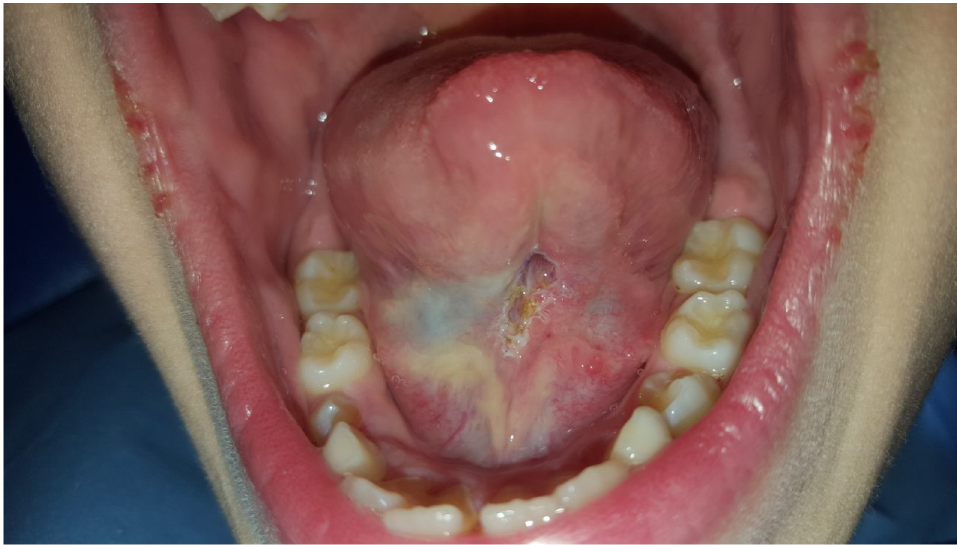
Figure 9. The situation immediately after surgery. It is possible to observe the lack of bleeding and the absence of edema.